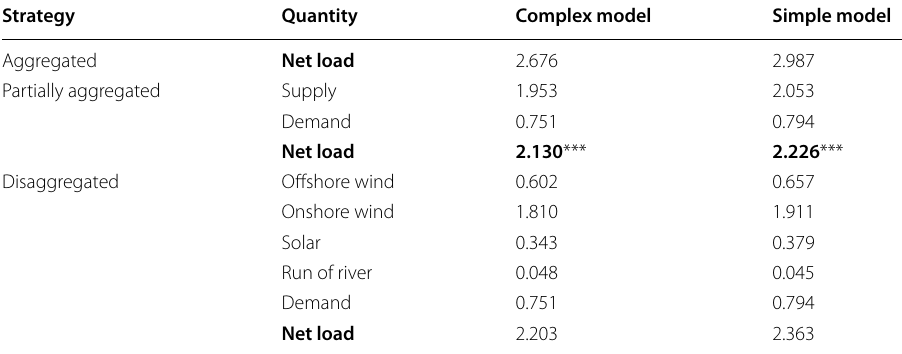
Table 6 CRPS calculated on the test set for the different probabilistic forecasting strategies